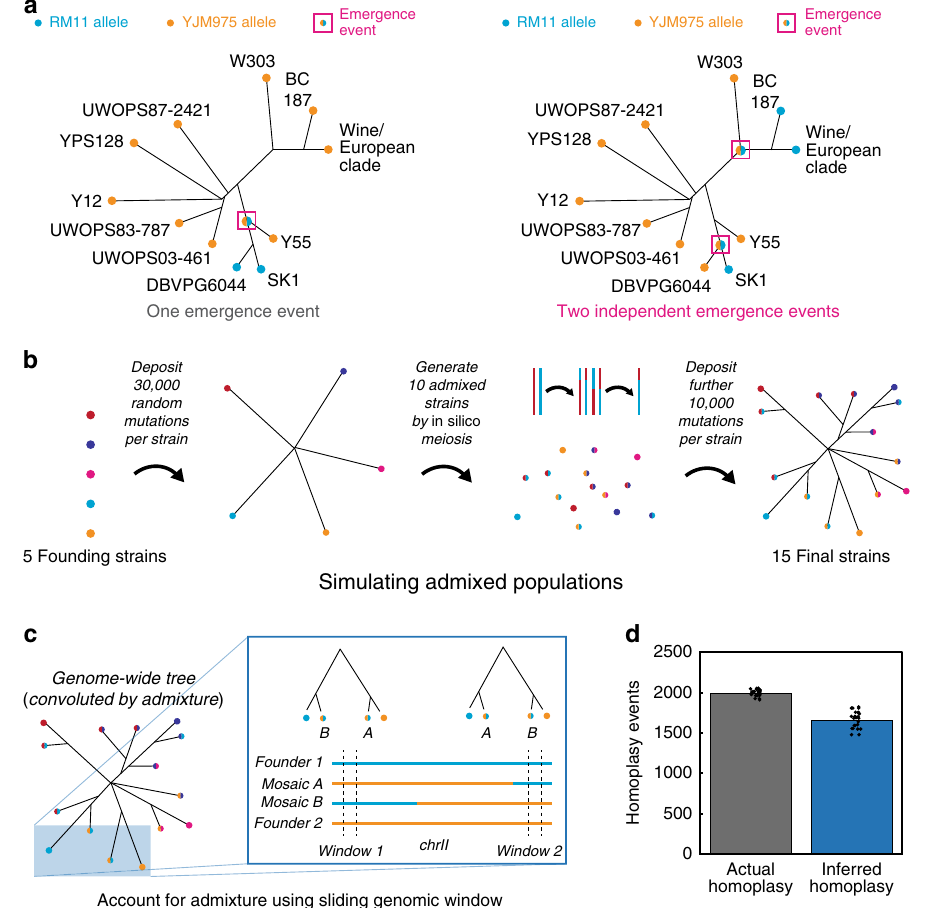
Fig. 5 Using local phylogeny to accurately infer homoplasy. a Example phylogeny of a hypothetical variant that (left) emerged only once and (right) independently emerged twice. b Schematic of the in silico mutagenesis and mating procedure used to generate simulated admixed populations. c Schematic of the sliding phylogenetic window approach used to account for admixture. d Actual and inferred homoplasy based on this approach for N = 25 simulated populations with structure similar to that of the SGRP collection; bars show the mean. Source data are provided as a Source Data fi